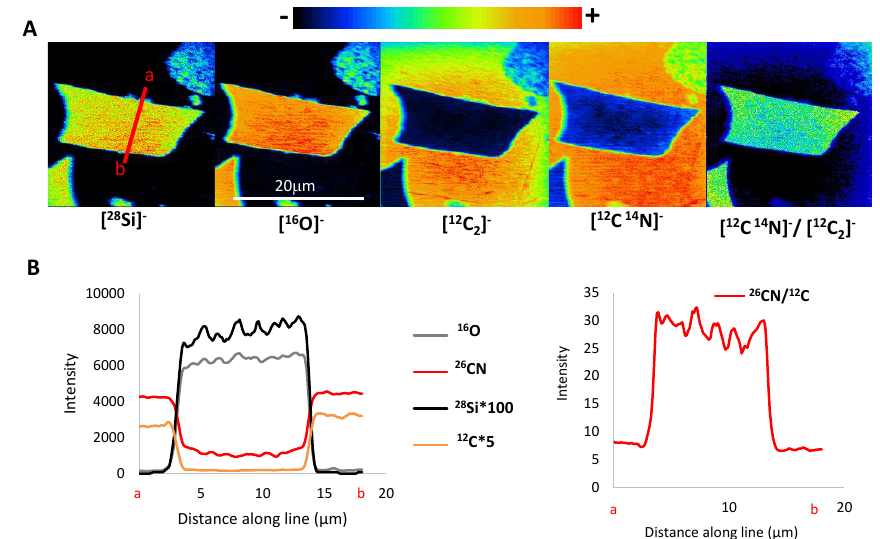
Figure 6. NanoSIMS images and intensities of a first typical GSC phytolith (rondel type) from TD-F-L (wheat) embedded in epoxy resin (pol- ished section). Pre-sputtering: L1 = 2kV de-focused (60 × 60mm) [Cs] + primary beam, for 3min (a) [ 28 Si] − , [ 16 O] − , [ 12 C 2 ] − , [ 12 C 14 N] − and [ 12 C 14 N] − / [ 12 C 2 ] − images obtained with a [Cs] + primary beam with L1 = 2kV, D1-1 primary diaphragm (750µm), for 11min; (b) secondary ion intensities along line scans (red line in a ).